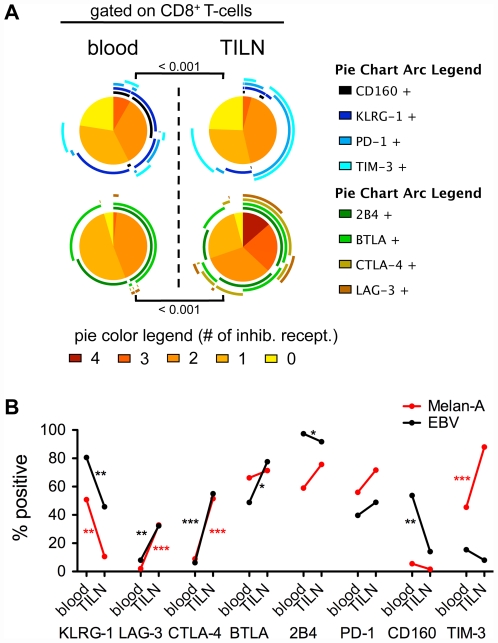
Expression of inhibitory receptors by CD8 T-cells derived from blood and tumor-infiltrated lymph nodes (TILNs).(A) Co-expression analysis of total CD8 T-cells. Colors of the pie arcs depict the expression of individual inhibitory receptors, while the color in the pie depicts the number of co-expressed inhibitory receptors. Co-expression was analyzed with SPICE 5.2. n = 9/8 (TILN) and 31/17 (blood) for staining 1 and staining 2 respectively. (B) Melan-A- (red) and EBV- (black) specific CD8 T-cells. Positivity for the inhibitory receptor was defined respective to isotype controls. Blood samples were from patients vaccinated either with CpG-ODN or without CpG-ODN. n = 20/21 (blood; Melan-A/EBV) and n = 9/6 (TILN; Melan-A/EBV) for staining 1; n = 23/24 (blood; Melan-A/EBV) and n = 8/5 (TILN; Melan-A/EBV) for staining 2 except BTLA, and n = 8/7 (TILN; Melan-A/EBV) for BTLA.